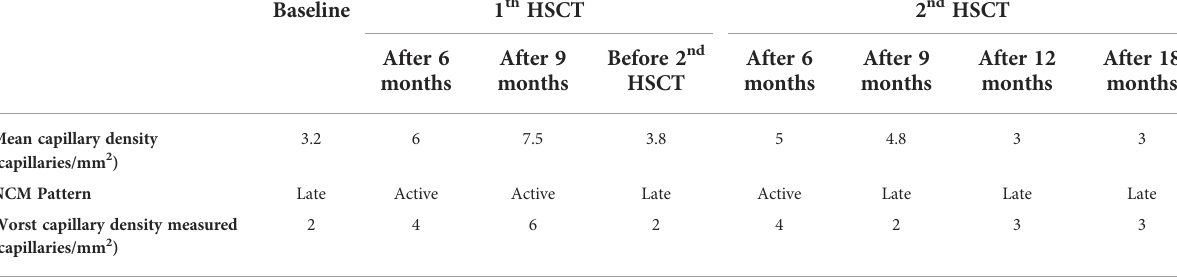
TABLE 1 Capillary density and NCM pattern at baseline and after 1 th and 2 nd